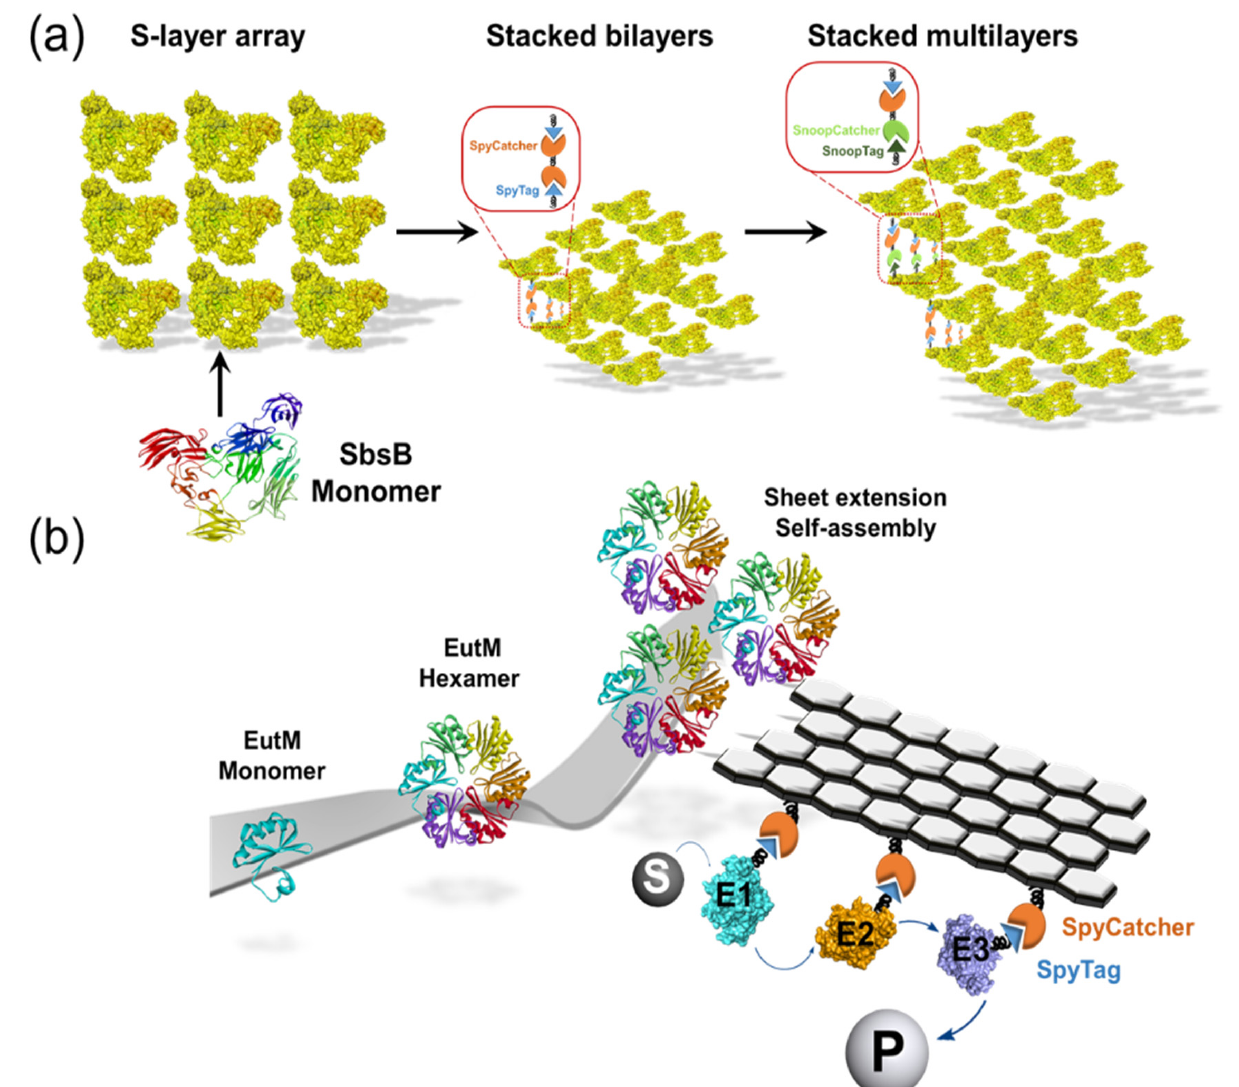
Figure 4. Self-assembling protein scaffolds. ( a ) Arrays are assembled from the bacterial S-layer protein SbsB. Genetic engineering S-layer proteins for Spy/SnoopTag display facilitates the stacking of layers with bifunctional Spy/SnoopCatcher domain proteins [154]. ( b ) Scaffolding system for multi-enzyme biocatalysis. The bacterial microcompartment shell protein EutM assembles into hexameric arrays to which biocatalysts can be attached via N- or C-terminal genetic fusion of interacting polypeptide tags like the SpyTag/SpyCatcher pair. The spatial organization of enzyme cascades is optimized by varying the molar ratios of catalysts and scaffold building blocks. A scaffold toolbox created from EutM homologs provides access to arrays with different assembly and surface properties for enzyme cascade optimization [46].